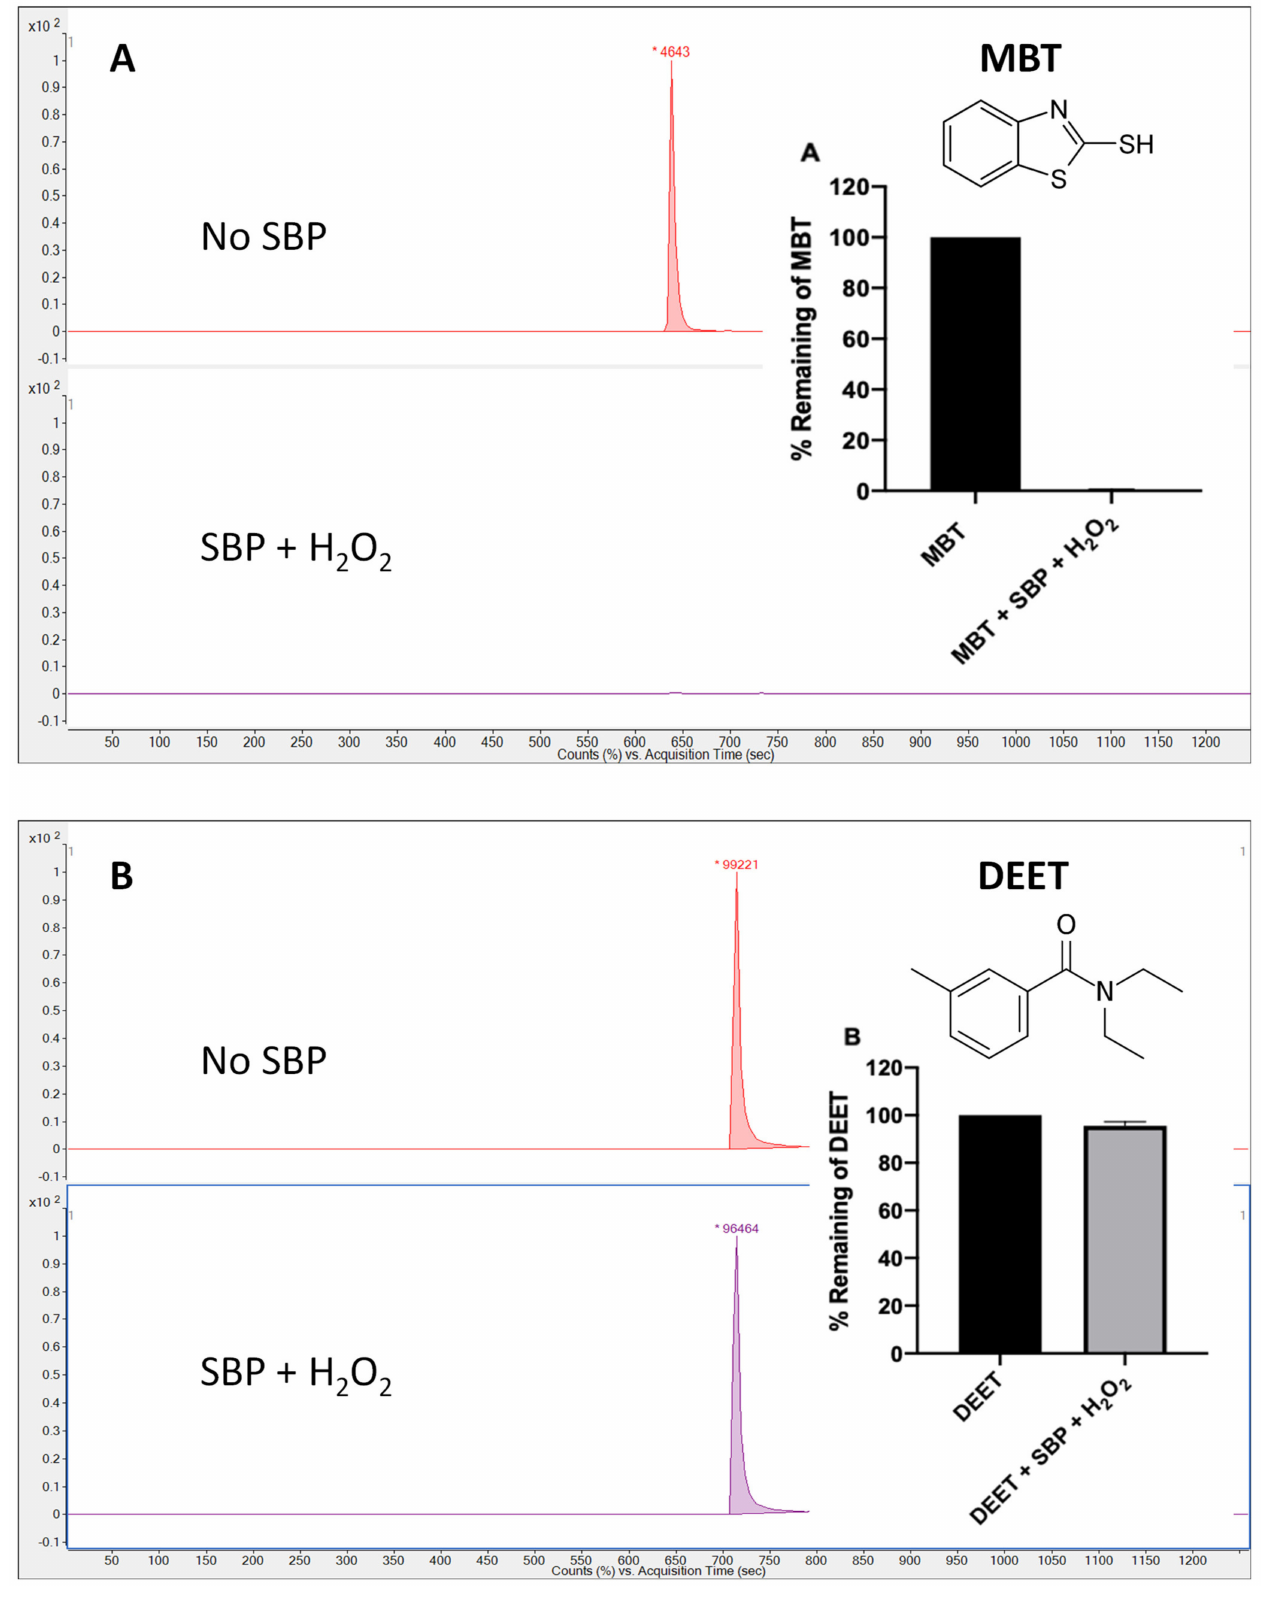
Figure 2. MRM scans of ( A ) MBT; and ( B ) DEET treated with SBP. [Pollutants] = 2 ppm, [Enzyme] = 0.39 µ M, [H 2 O 2 ] = 0.3 mM (0.1 mM added 3 times of 10 min interval), pH =